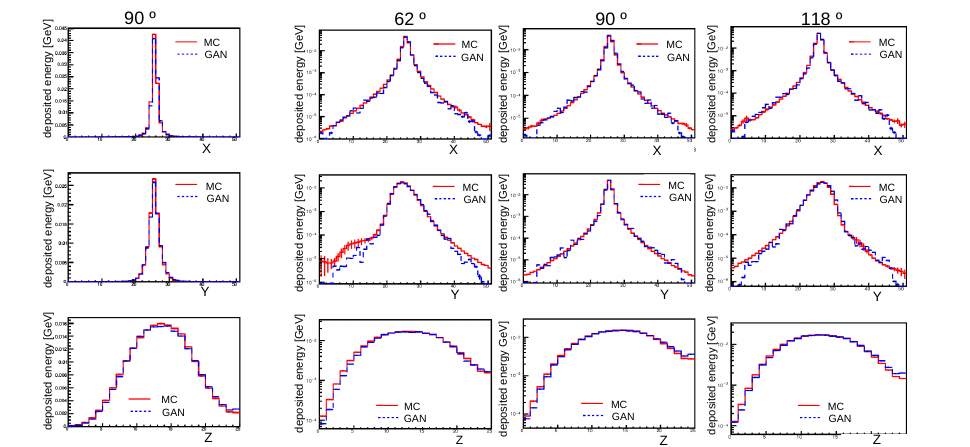
Figure 4. Shower shapes for Geant 4 vs. GAN events along x , y and z axis:left) for 90 ◦ incident angle, in linear scale; right) for 62 ◦ , 90 ◦ and 118 ◦ , in log scale.